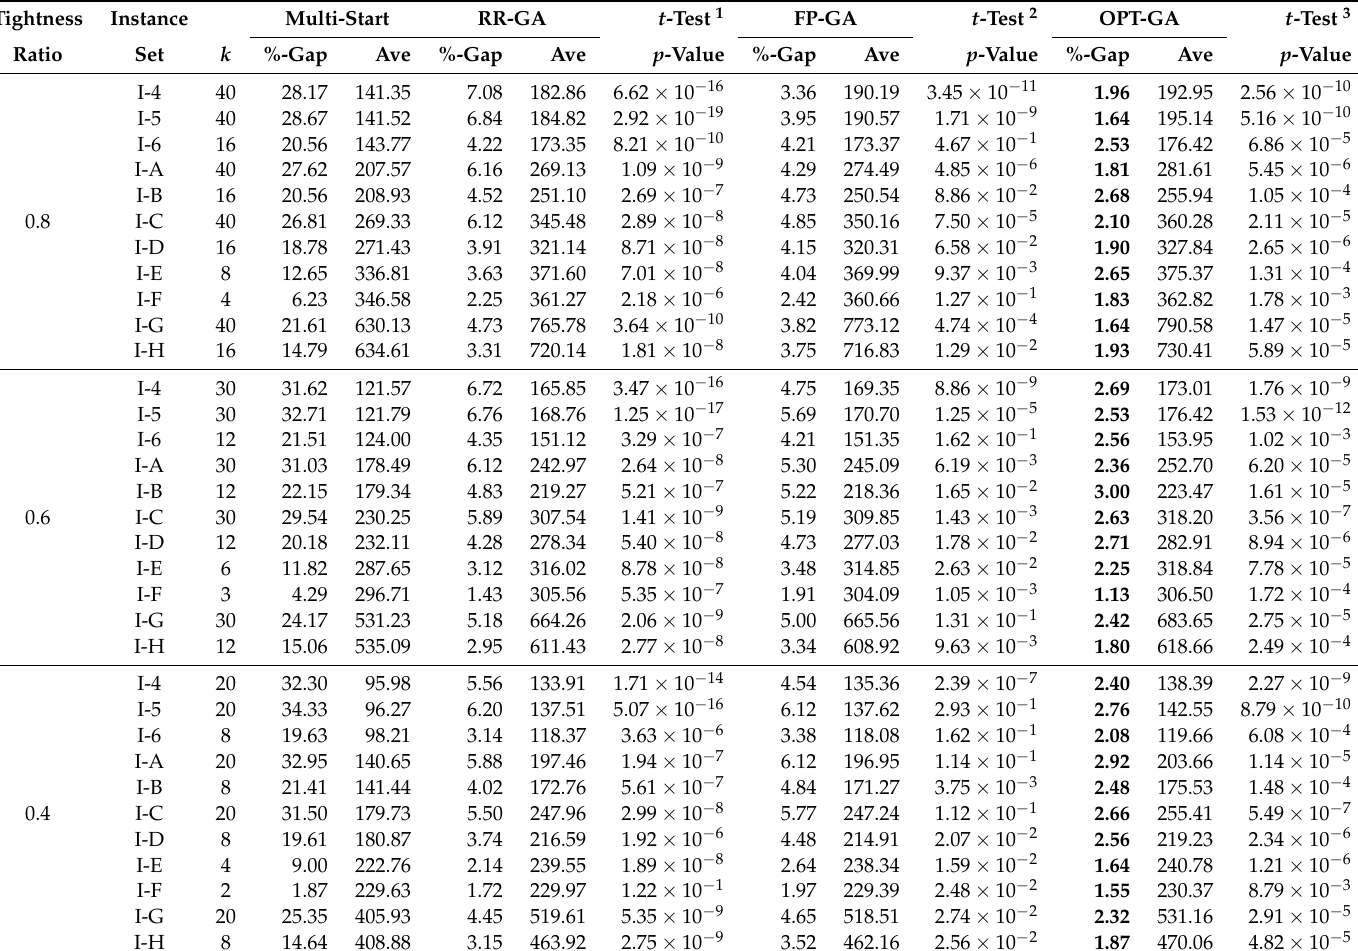
Table 3. Results of three GAs compared with random solutions to